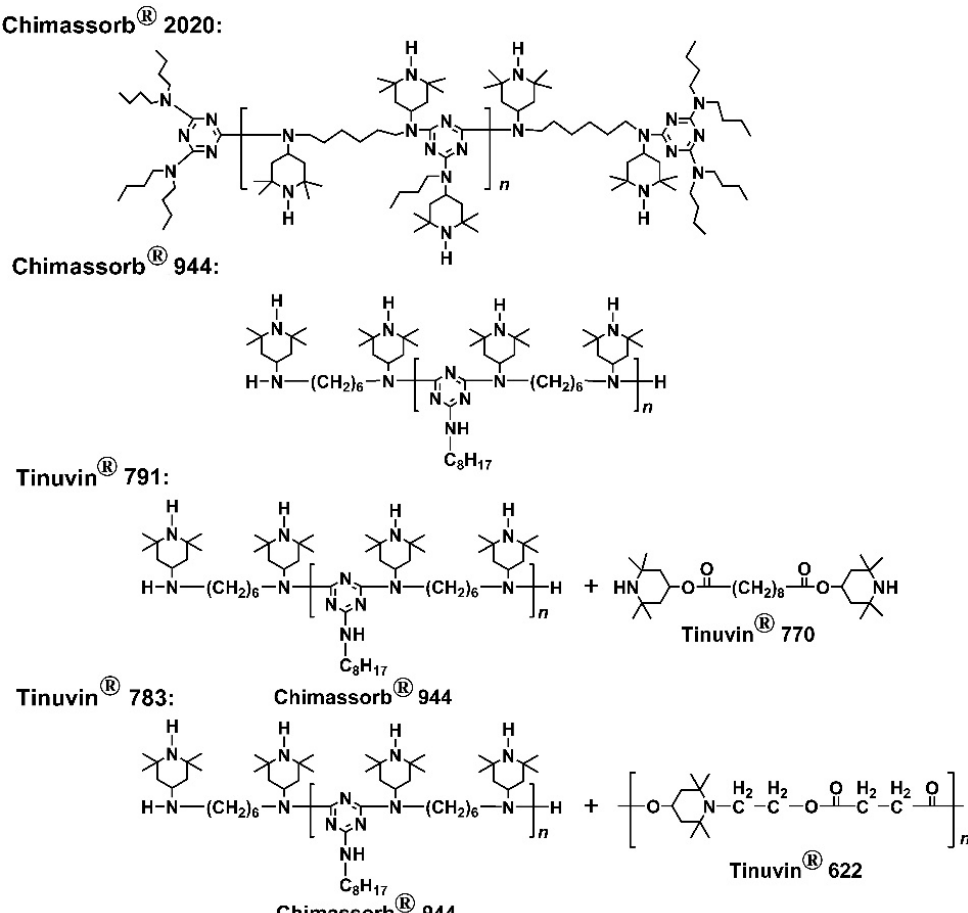
Figure 1. Commercially available hindered amine light sensitizers (HALS) used for the preparation of CPI/HALS nanocomposite films (Source: supplier).